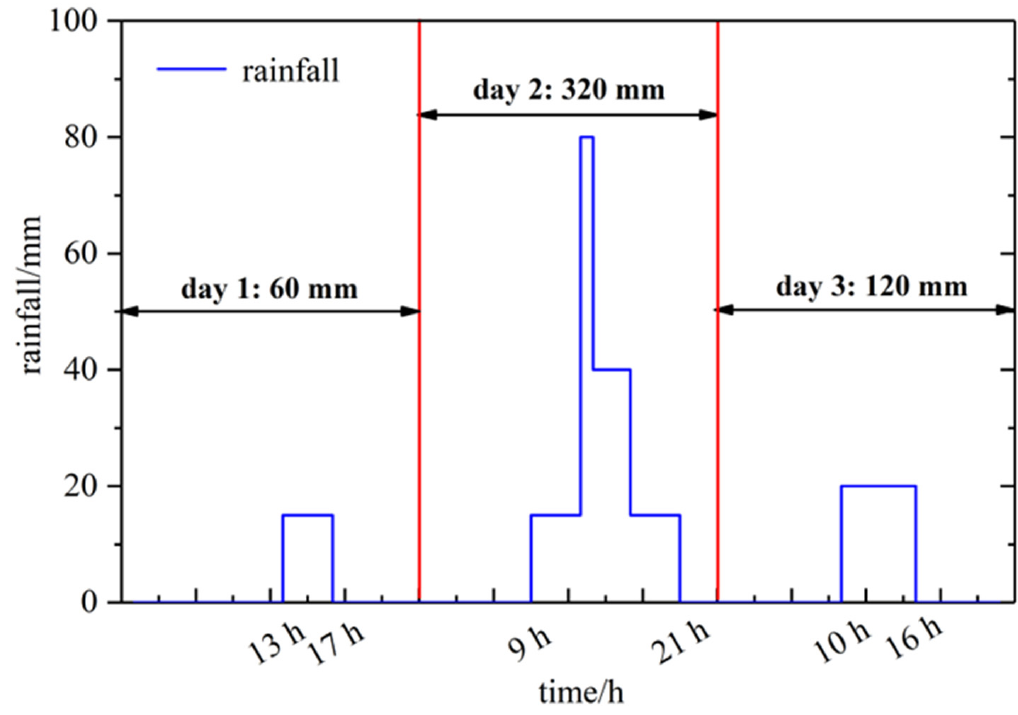
Figure 5. Rainfall simulation condition in this experiment.